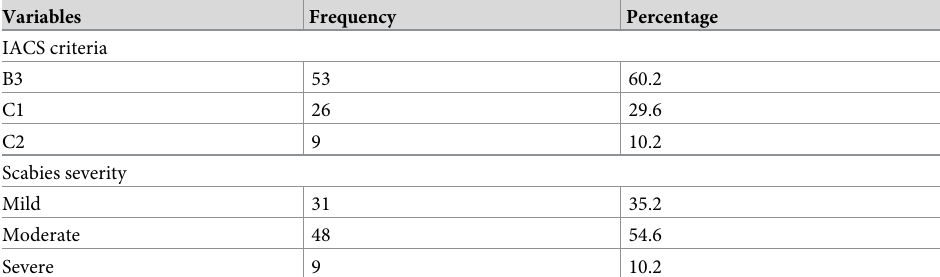
Table 5. Prevalence of scabies and its diagnostic character by 2020 IACS criteria among children aged 5–14 years in Meta Robi District, Ethiopia, 2020 (N = 457).